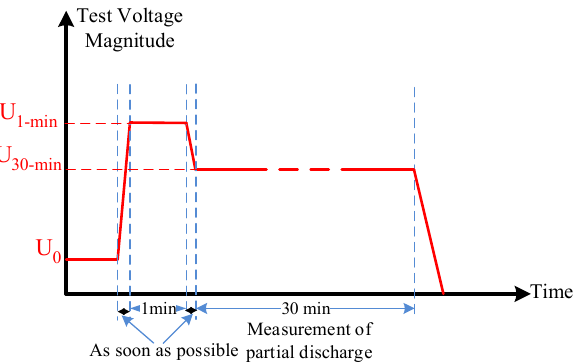
Figure 5. Method of applying a partial discharge test voltage.